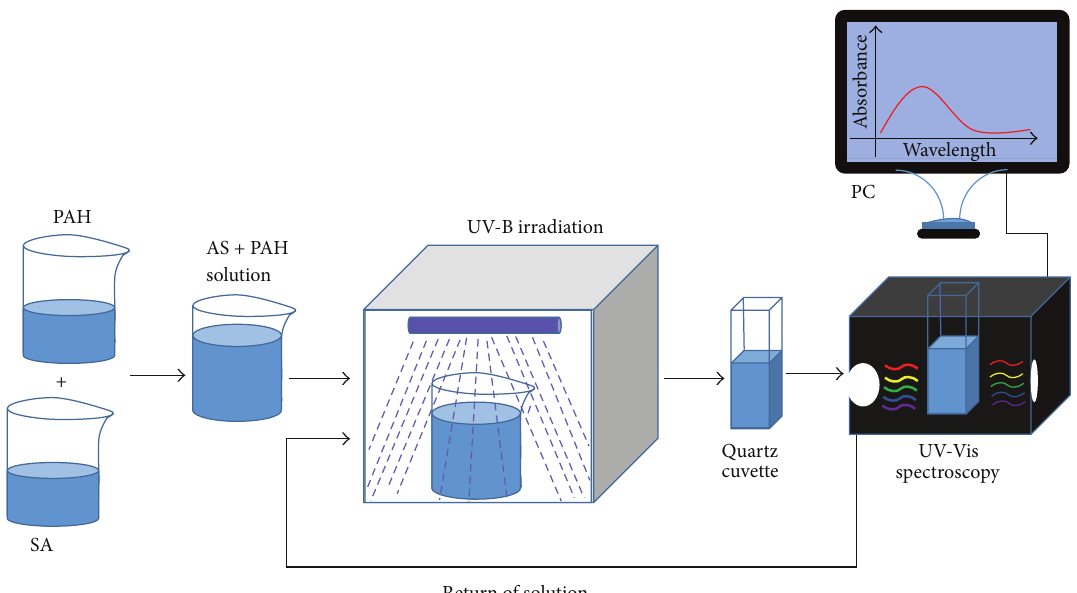
Figure 2: Schematic diagram of the irradiation procedure of SA + PAH solution.